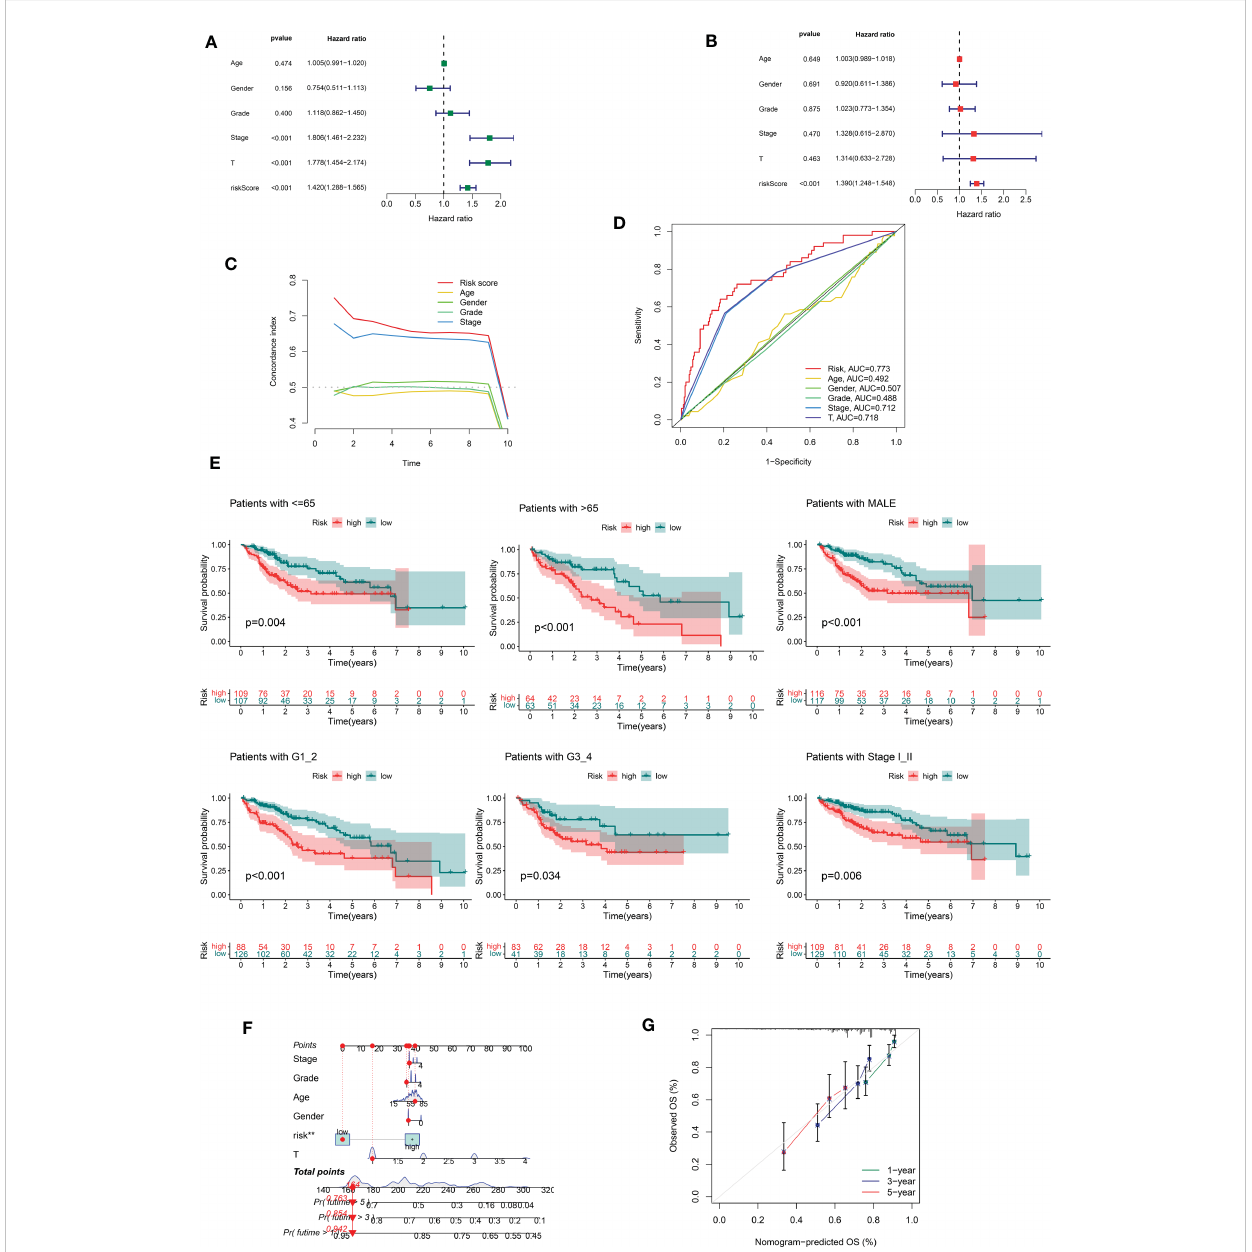
FIGURE 3 Correlations between risk score and different clinicopathological characteristics of HCC in the entire cohort. (A) Forest plot for univariate Cox regression analysis. (B) Forest plot for multivariate Cox regression analysis. (C) C-index for risk score. (D) ROC analysis of 1-year overall survival for multiple prognostic indicators of HCC samples. (E) Clinical strati fi cation analysis of overall survival of patients with HCC in the high- and low-risk groups by age, gender, histological grade, and tumor stage. (F) Nomogram combining CRDELSig and clinicopathological characteristics for predicting prognosis of HCC patients in the training cohort. ROC analysis of the predictions of 1-, 3-, and 5-year survival by the nomogram in the training cohort. (G) Calibration curve analysis of the nomogram for the probability of overall survival at 1, 3, and 5